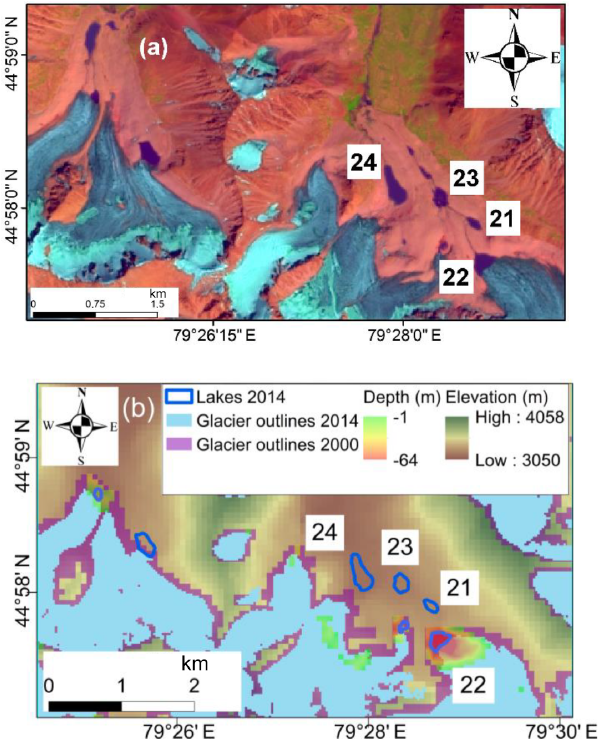
Figure 9. (a) Cascade of lakes in the Aksu basin (Landsat scene from 2014) and (b) modelled overdeepenings using the glacier mask from 2000 and actual lakes as in 2014.